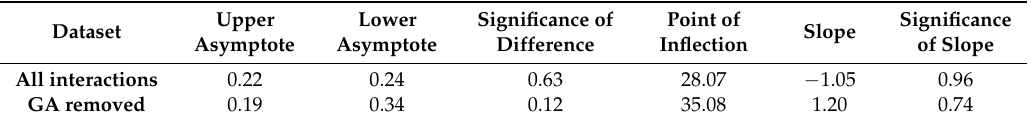
Table 1. Estimated parameters for the logistic regression curves across combined days of the virtual fence activation period for all 10 individuals (Animal 5 was excluded due to errors in collar functionality) 1 .